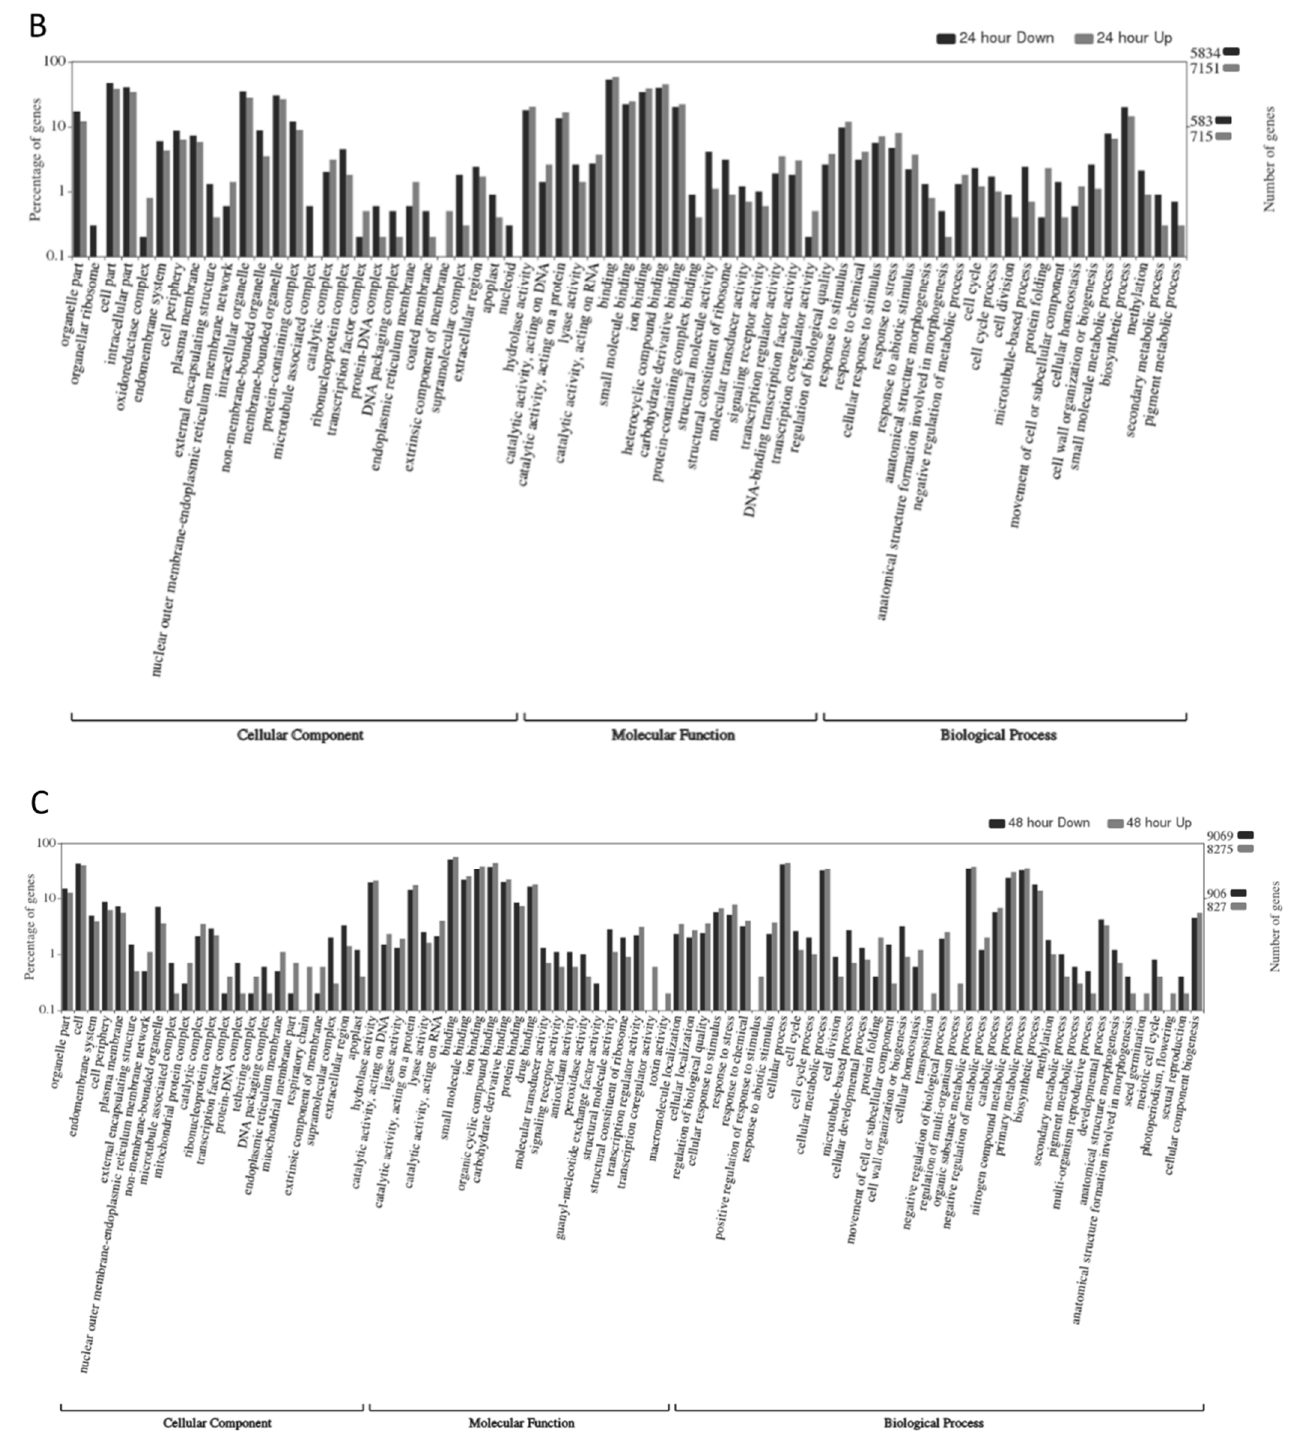
Figure 4. Gene ontology analysis for DEGs up- and down-regulated in response to heat/drought stress after ( A ) 12 h exposure, ( B ) 24 h exposure, and ( C ) 48 h exposure. Black bars = down-regulated DEGs; Gray bars = up-regulated DEGs. Numbers on the left-hand axis represent the percentage of genes (displayed on a log 10 scale). Numbers on the right axis represent the number of total DEGs (top numbers) and 10% of the DEGs (middle numbers) contained in up-regulated (gray) and the down-regulated (black) datasets used in analysis.